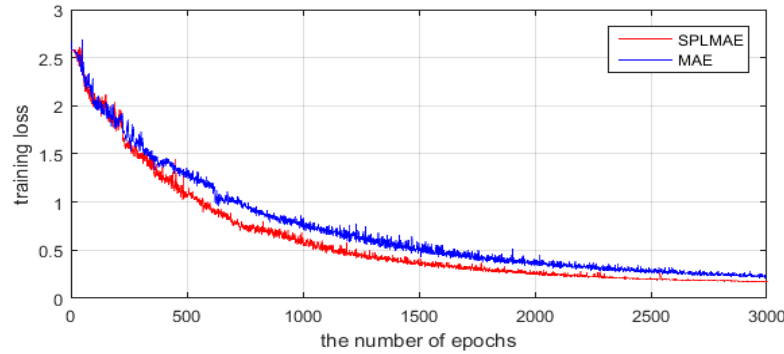
Figure 3. ( a ) Pauli RGB; ( b ) Ground truth; white area denotes unlabeled pixels.